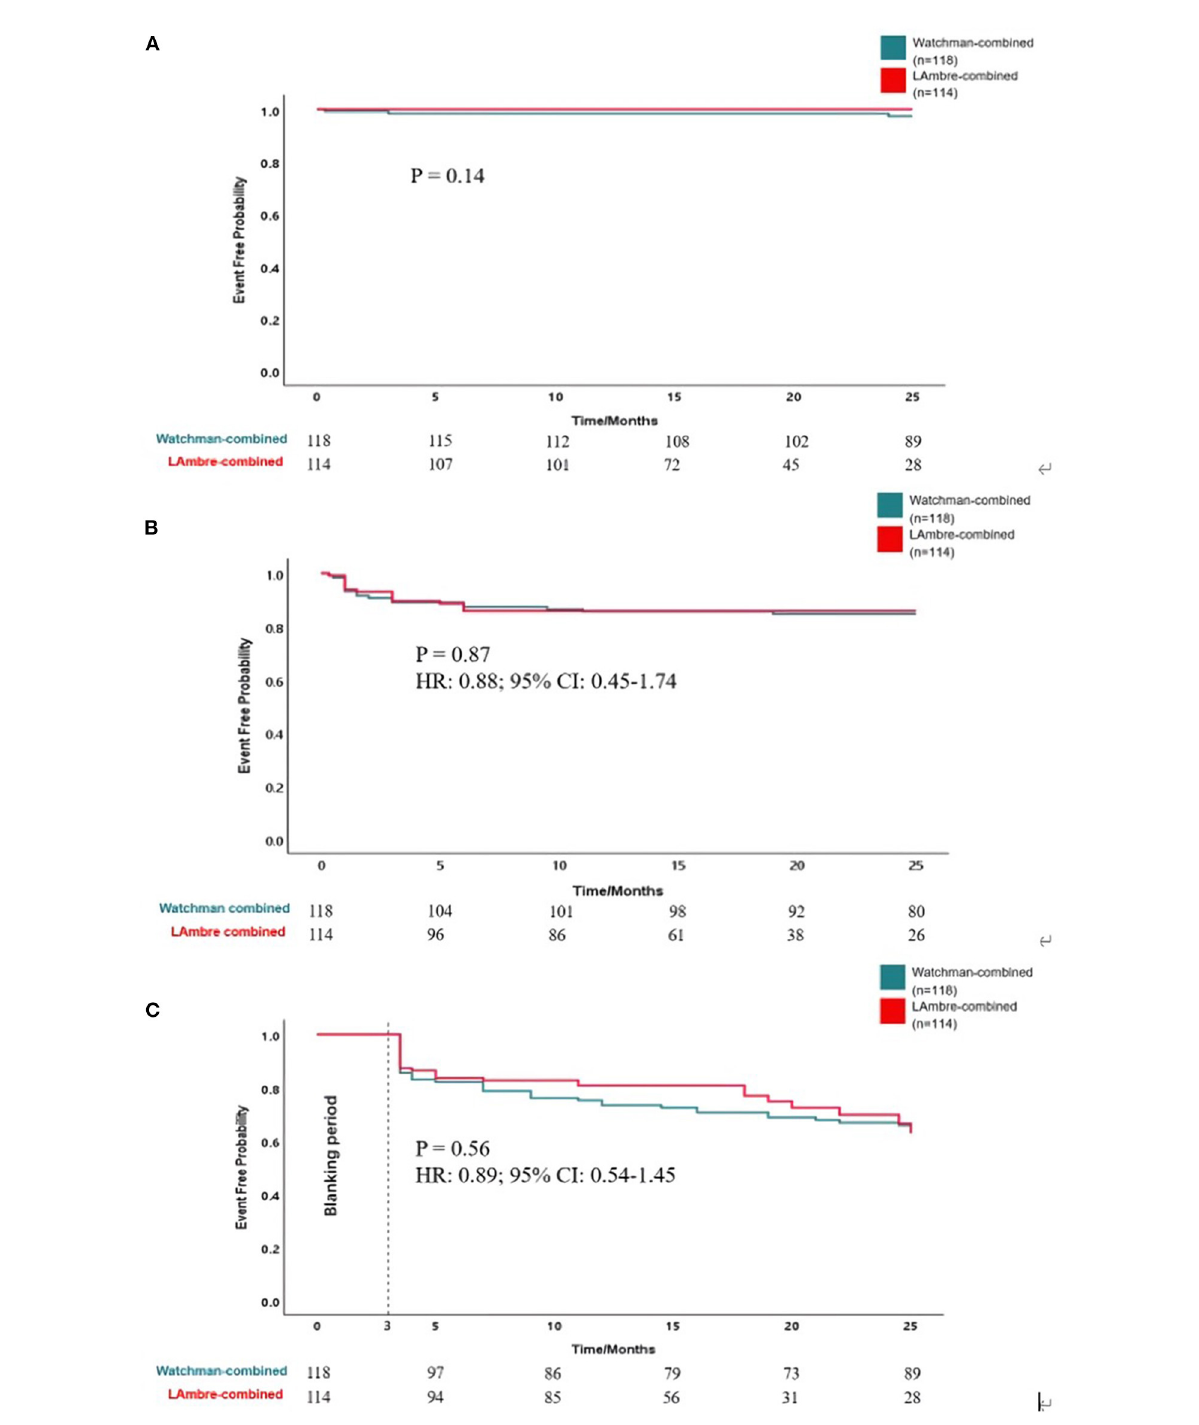
FIGURE2 Kaplan-Meier curves of (A) freedom from all-cause stroke, TIA and death, (B) freedom from bleeding events, and (C) freedom from atrial fibrillation